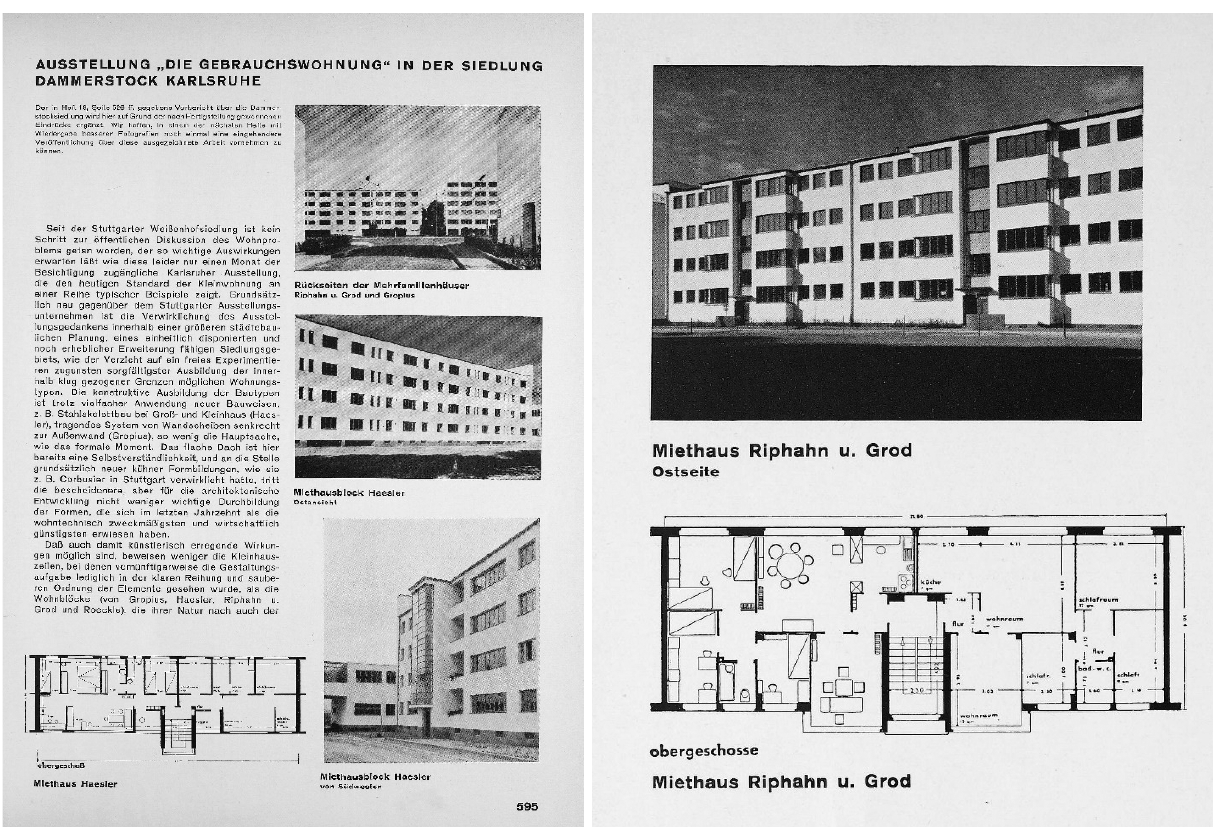
Figure 5. W. Riphahn and C. M. Grod, Dammerstock-Siedlung, multi-storey buildings, rental house. Source: Atelier Bauer